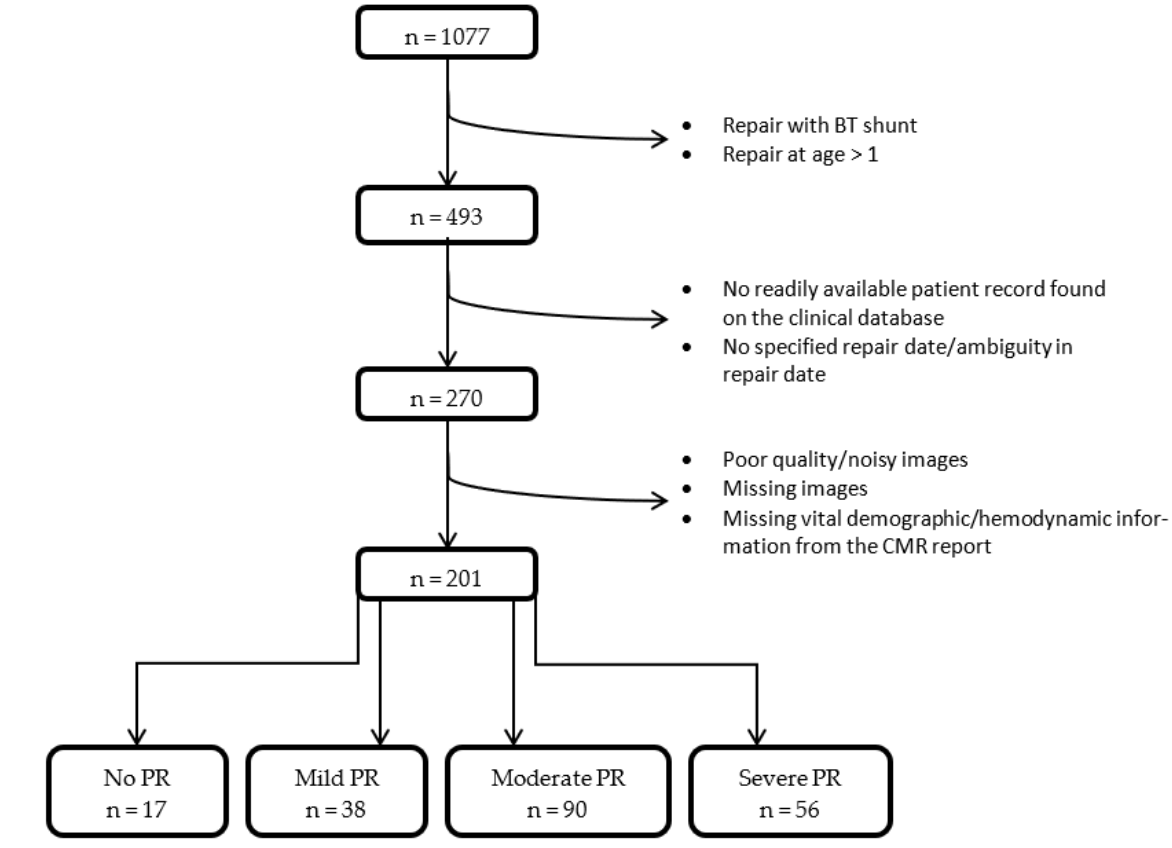
Figure 1. Flow chart of patient selection. BT = Blalock–Taussig, CMR = cardiovascular magnetic resonance, PR = pulmonary regurgitation. Table 2. Summary of wave-intensity and wave-speed results. FCW = forward compression wave, FEW = forward expansion wave, PR = pulmonary regurgitation.